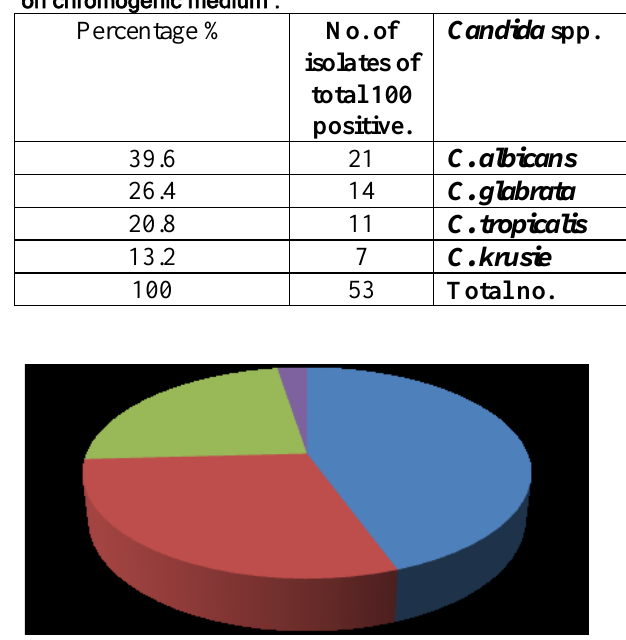
Figure 5 Percentage of Candida spp according to its appearance on